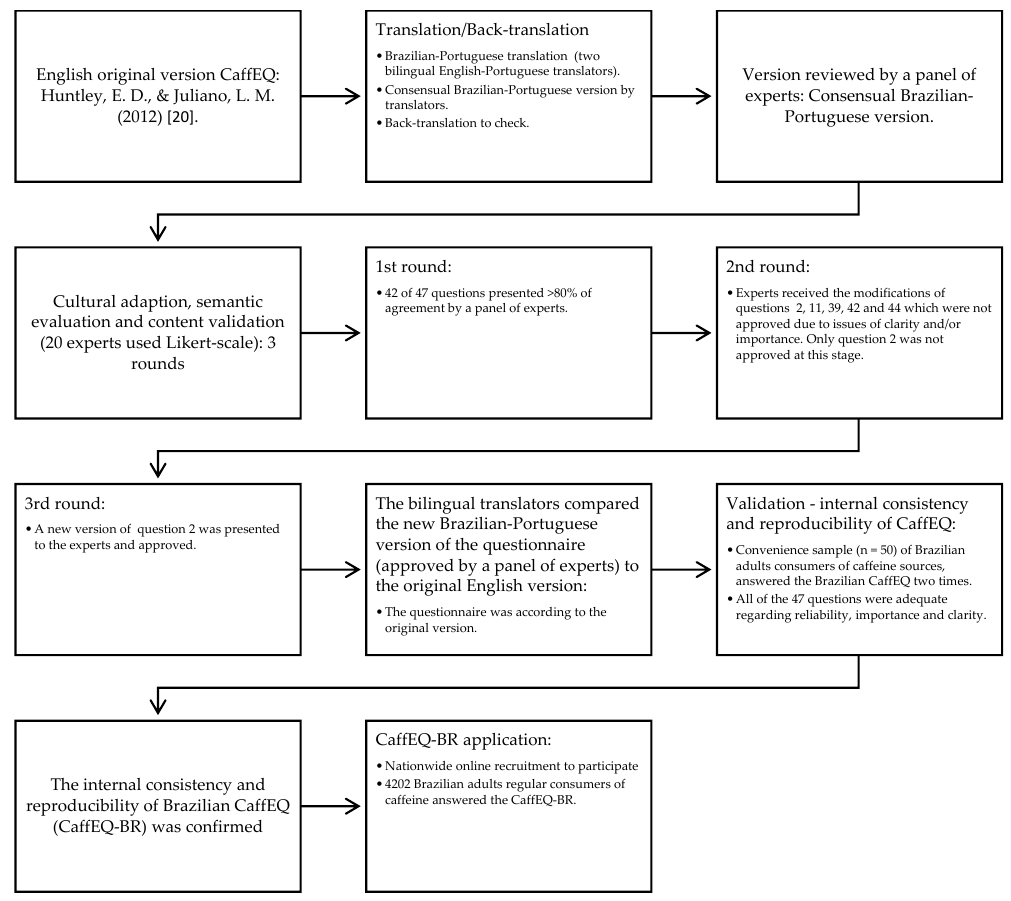
Figure 1. Flowchart of translation, cultural adaptation, semantic evaluation, content validation processes and application of the Caffeine Expectancy Questionnaire in Brazil (CaffEQ-BR).